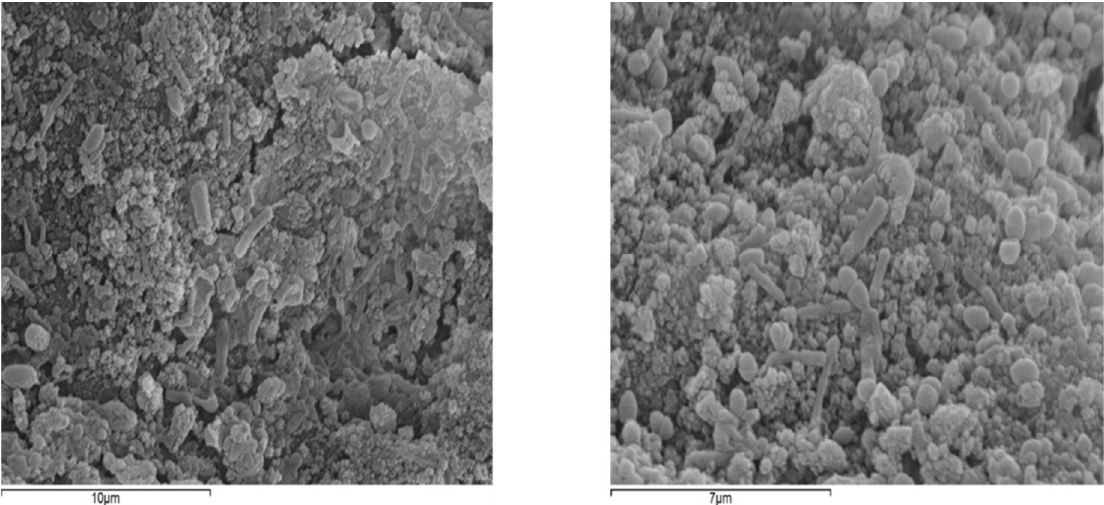
Figure 2. SEM images of the immobilized mixed anaerobic culture cells on γ-alumina pellets.